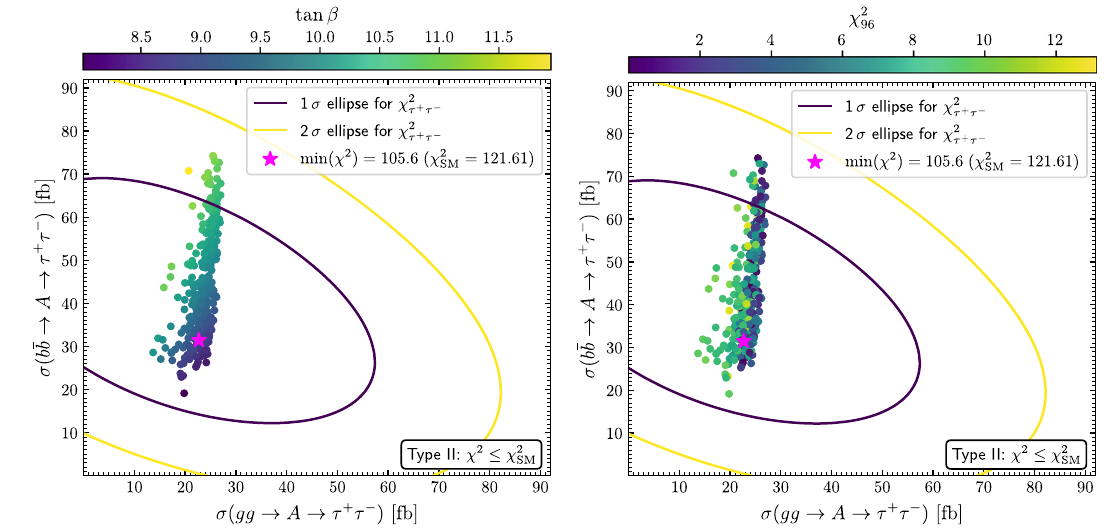
Fig. 8 Signalcrosssectionsof A → τ + τ − forthe gg productionmode on the horizontal axis and the b ¯ b production mode on the vertical axis. The colors of the points indicate the value of tan β (left) and χ 2